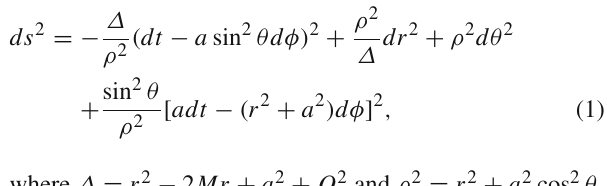
Fig. 1 The spin parameter a dependence of the radial coordinate r for the different values of electric charge Q . The values assigned to Q (top to bottom) are 0,0.2,0.4,0.6 and